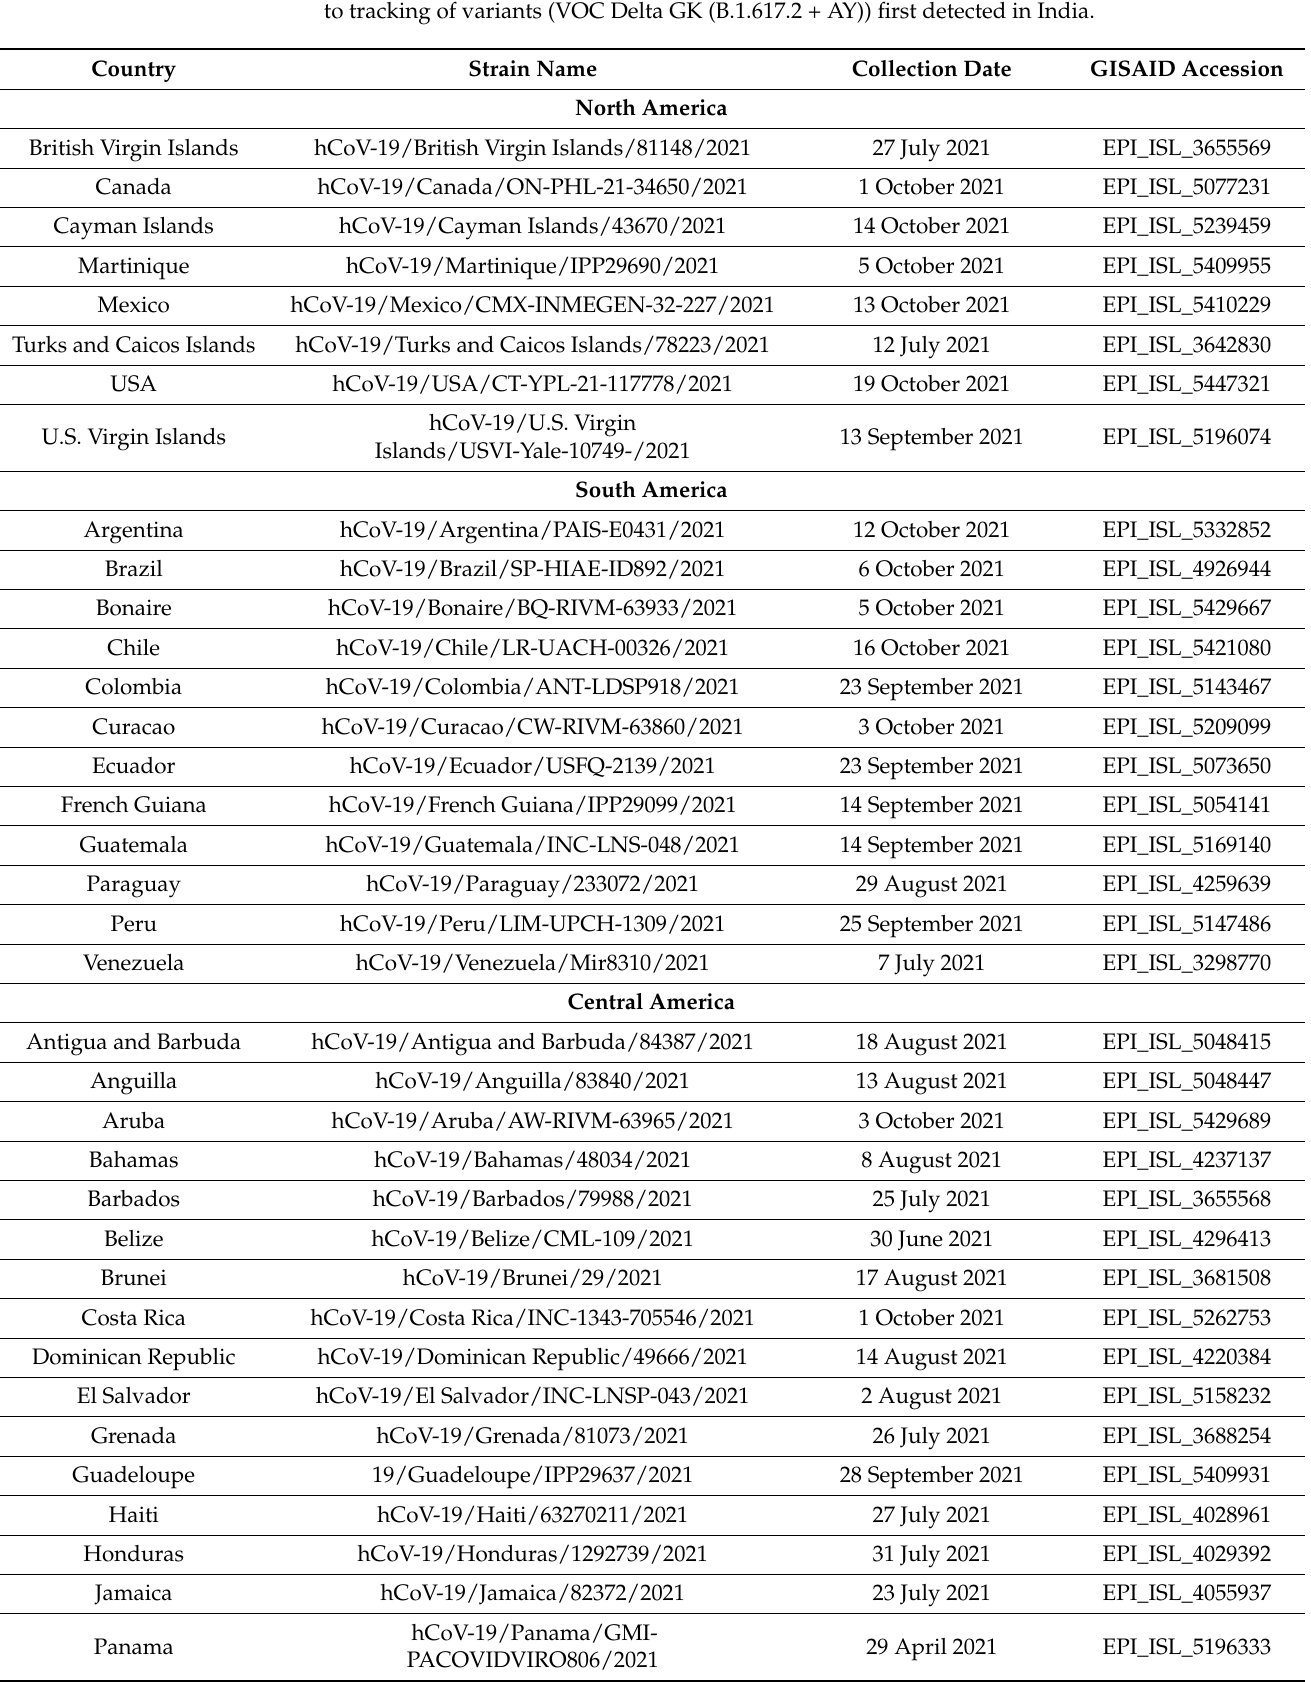
Table 5. Most recent reported occurrences in different countries on the American continent